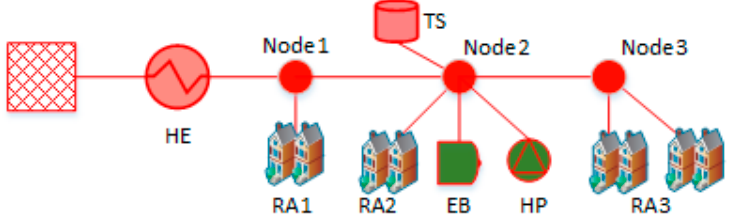
Figure 4. Equivalent district heating distribution network near Århus, Denmark.